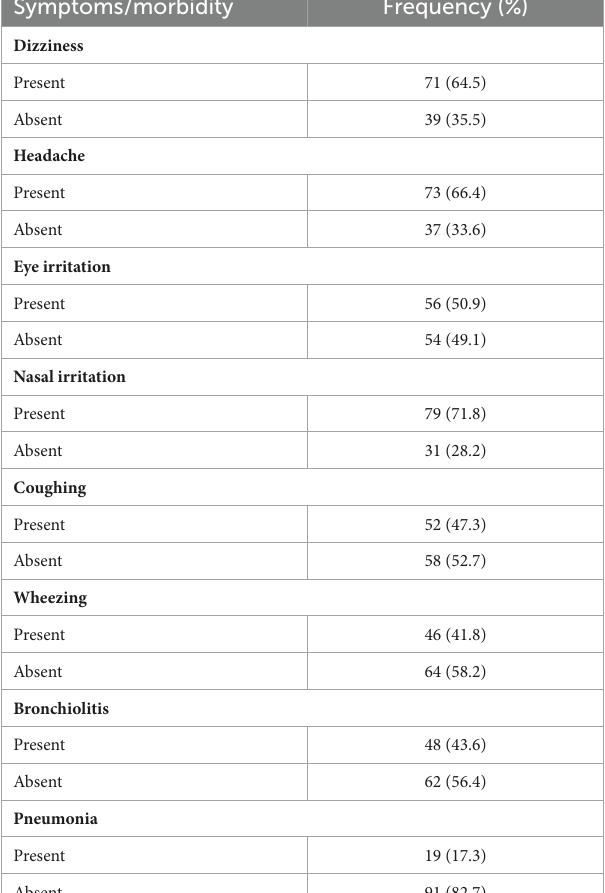
TABLE 5 The occurrence of common symptoms/morbidities among respondents due to biomass use.